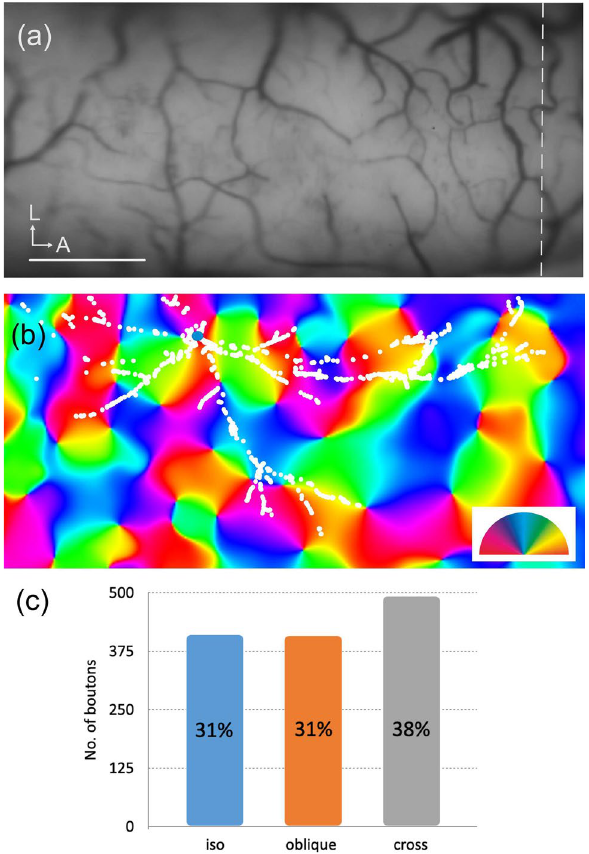
Figure 8. ( a ) Green-image shows the surface vascular pattern used for aligning the Neurolucida reconstruction of L6SC with the orientation map displayed below. Broken line indicates the ear-bar zero position. ( b ) Orientation map overlaid with boutons of L6SC. Only a subset of boutons (87%, white spots) could be taken into account being located within the imaged cortical region. The cell body (blue spot) was found in a region where many orientations converged as can be seen by the rapid change of colors according to the orientation scheme. ( c ) The graph shows the distribution of orientation preferences of boutons simplified as iso-, oblique- and cross-orientation with respect to the orientation preference at the soma location. Most boutons preferred cross-orientation (38%), while iso- and oblique orientations were equal (31% each). L lateral, A anterior, Scale bar ( a , b ): 1